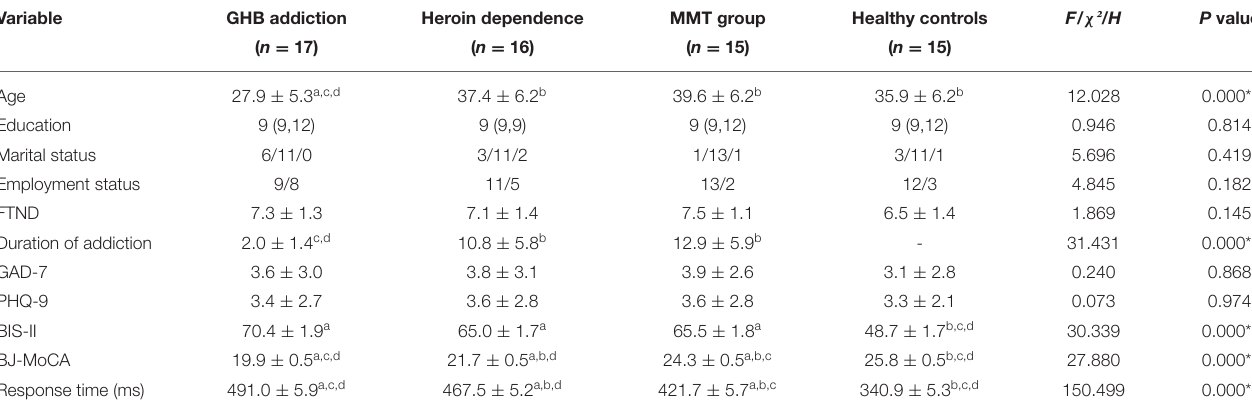
TABLE 1 | Demographics and clinical characteristics of the four groups. Variable